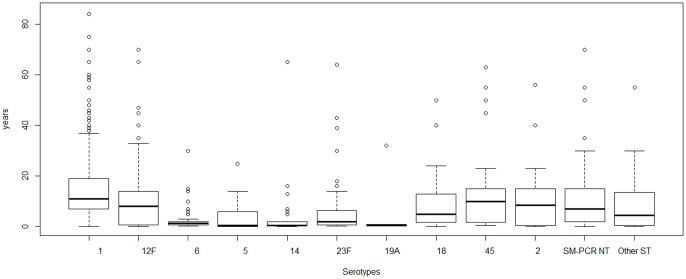
Age distribution for the prevalent serotypes.Box plots representing age according to serotype. Box plots provide distribution quartiles of 25%, 50%, 75% and 100%; Box length indicates interquartile ranges. Circles: outlier values; thick horizontal lines: median values; whiskers: range of values within 1.5 interquartile range.